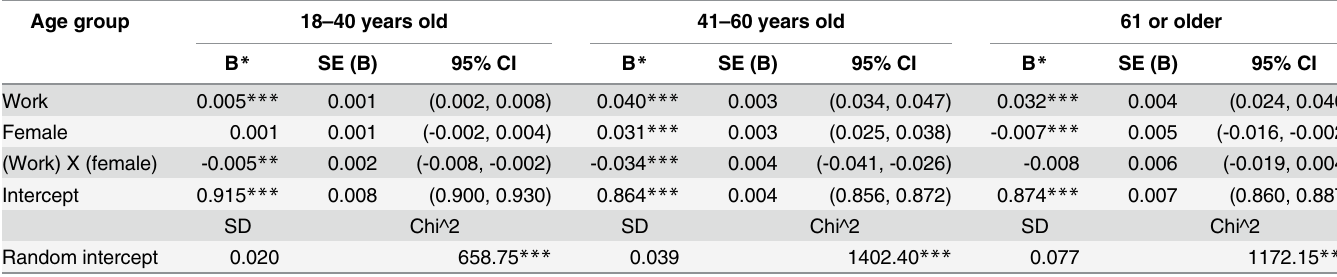
Table 3. Random effect panel regression model of EQ-5D by age